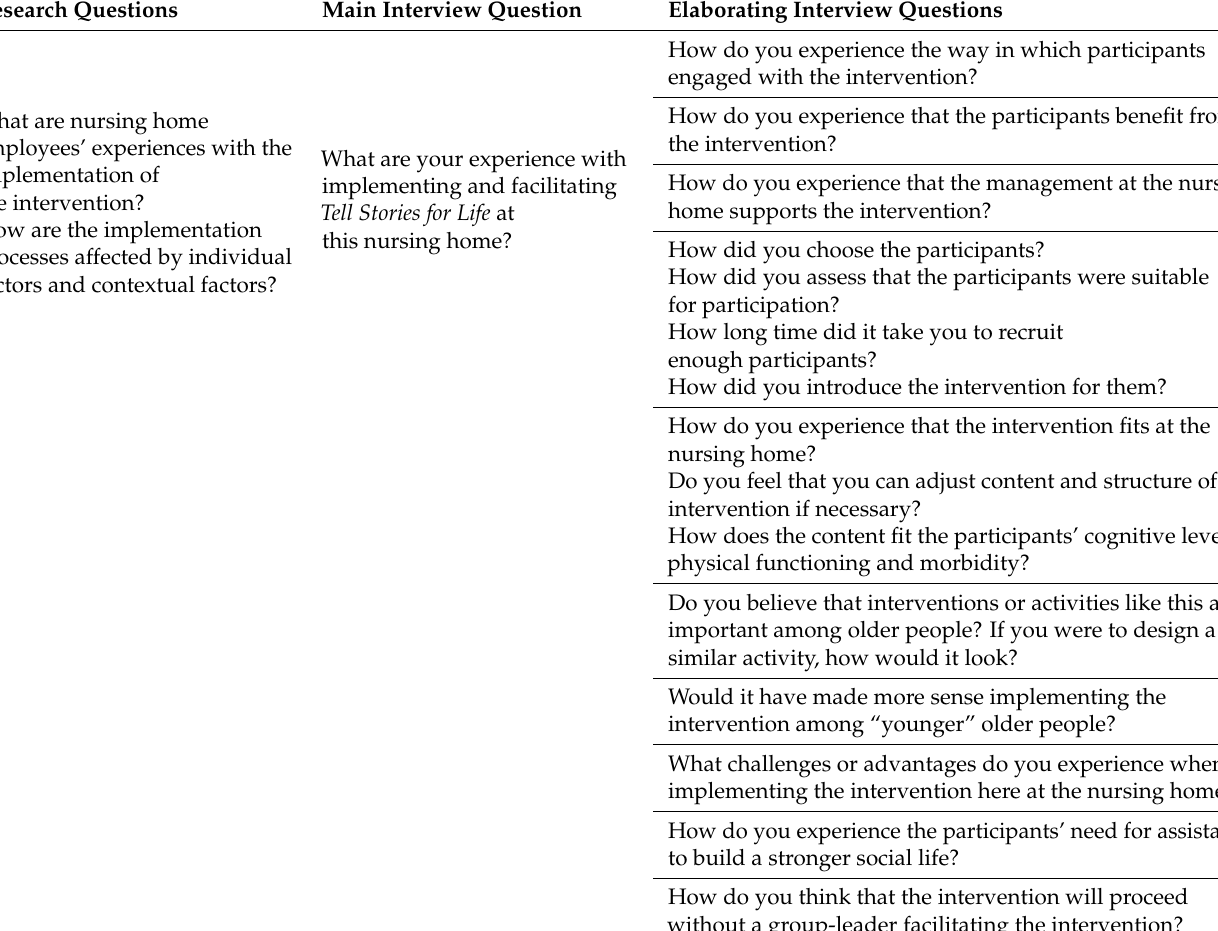
Table A2. Interview guide for nursing home